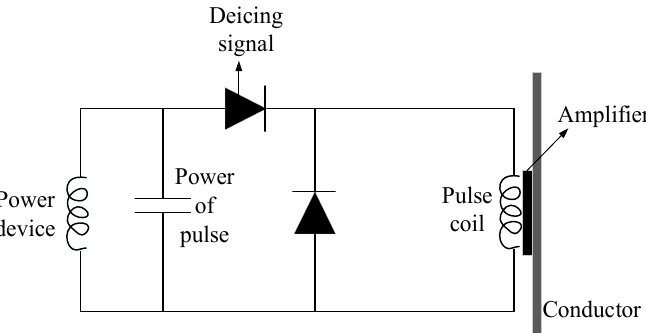
Figure 2. Schematic diagram of electromagnetic pulse de-icing.